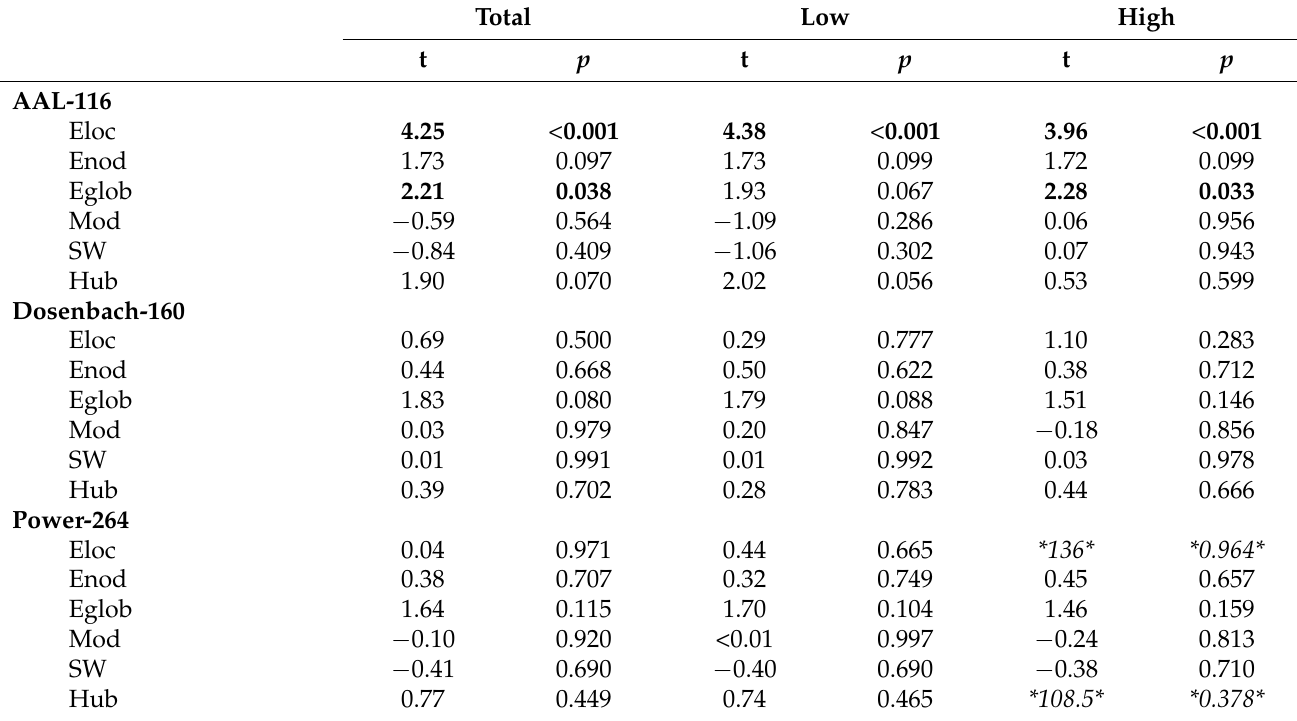
Table 1 for a list of all results. Table 1. Overview of all uncorrected